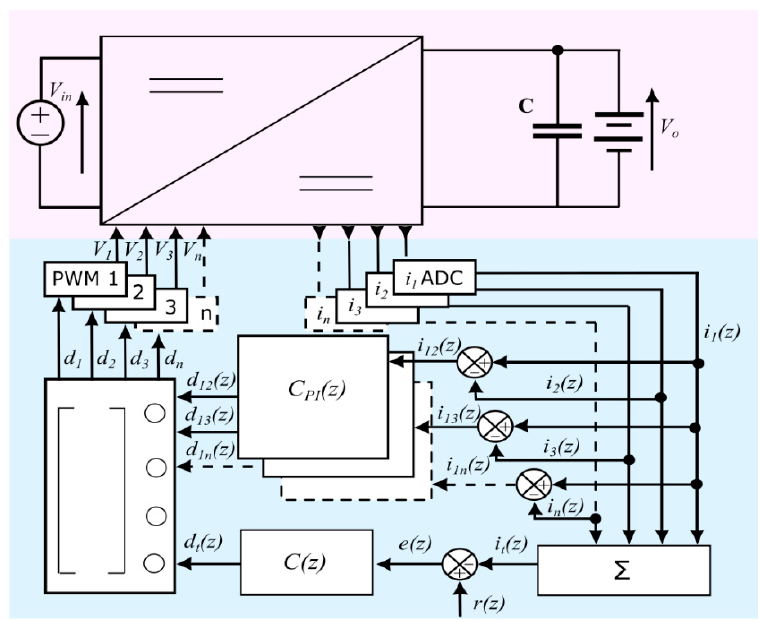
Figure 6. Block scheme of the buck converter and control system. The power circuit and the control scheme are respectively displayed with a pink and light blue background.